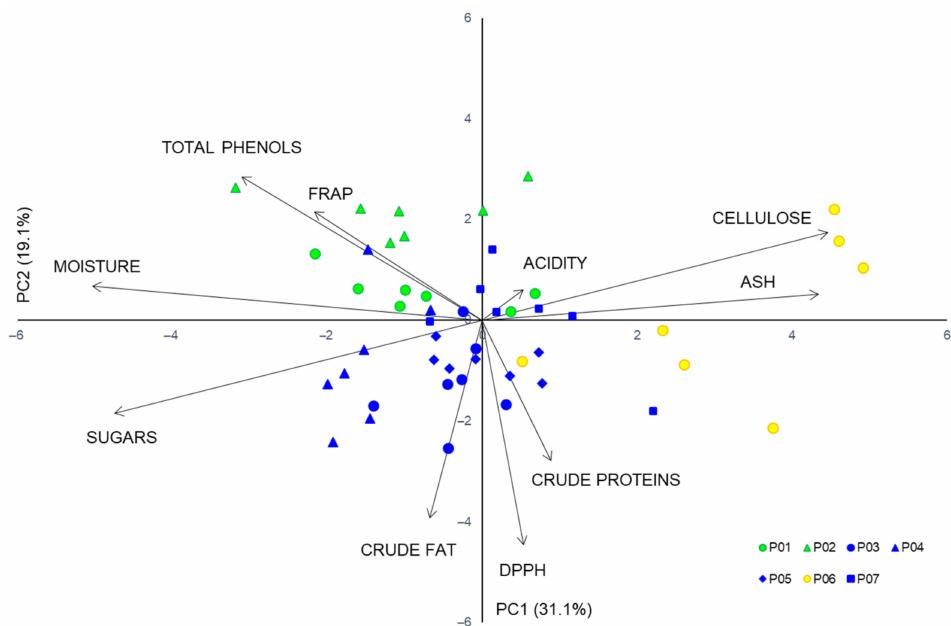
Figure 5. Biplot of the principal component analysis based on ten chemical traits in studied Sorbus domestica populations. Acronyms of populations: P01 (Psunj), P02 (Tounj), P03 (Istria), P04 (Novi Vinodolski), P05 (Split), P06 (Braˇc), and P07 (Konavle). Each point represents a single tree, with a color corresponding to cluster from K-means clustering method and origin of population: continental populations—cluster A (green); island population Braˇc—cluster B (yellow); and coastal Mediterranean populations—cluster C